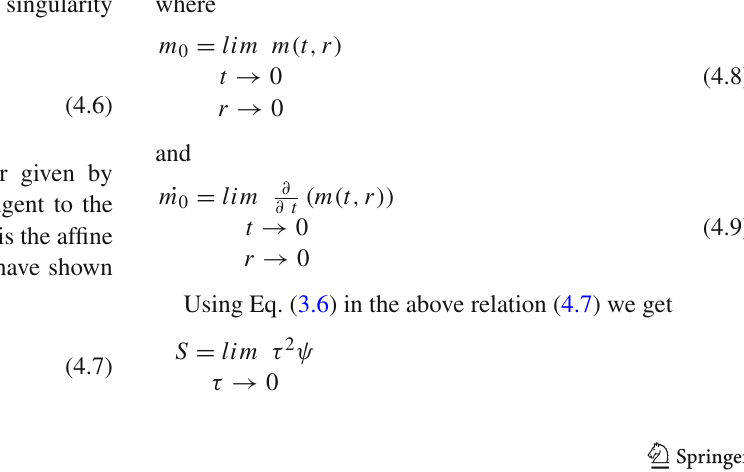
Figs. 3 and 4 Show the variation of slope X 0 of outgoing radial null geodesic at r = 0 in Penrose diagram as a function of the equation of state parameter k for different values of γ and V 0 respectively in Brans–Dicke gravity’s rainbow. In Fig. 3 the other parameters are fixed